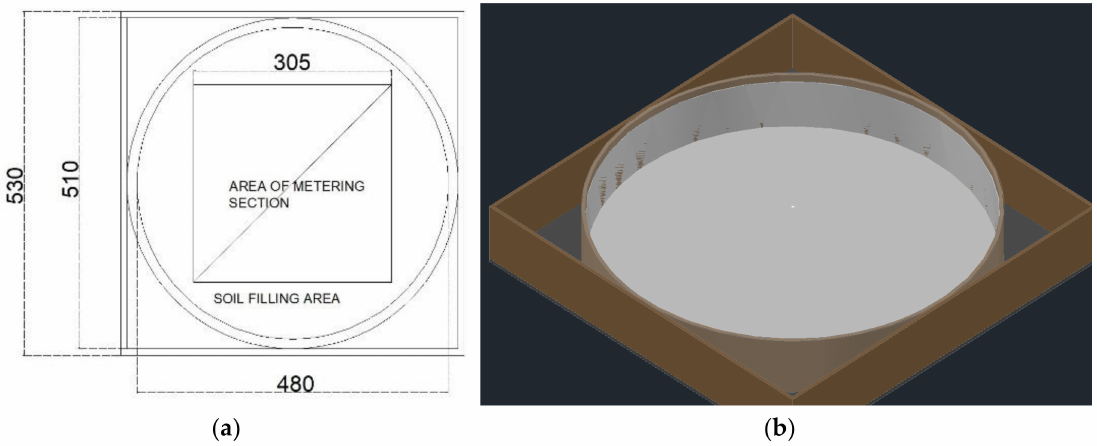
Figure 3. Sample containment box: technical description ( a , dimensions are expressed in mm) and 3D render ( b